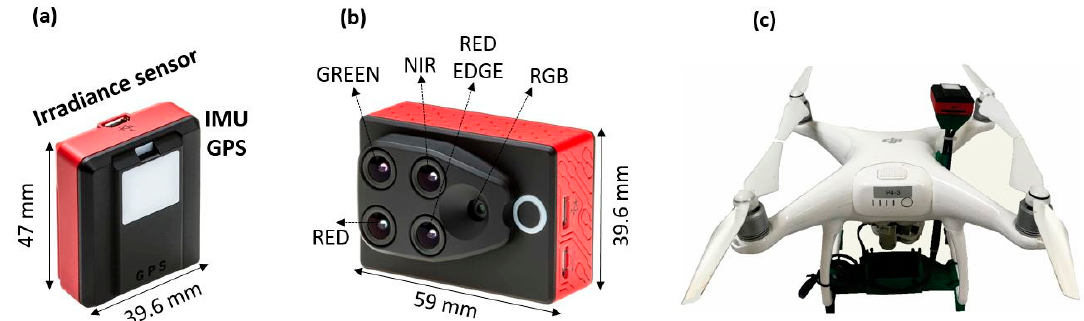
Figure 5. Lightweight unmanned platform highlighting the Sequoia’s accessory piece ( a ), the Sequoia ( b ), and its package placed in the 3D mount onboard the DJI Phantom 4 UAV ( c ). Table 1. Sequoia camera and specifications of the multispectral bands and RGB lens. Lens